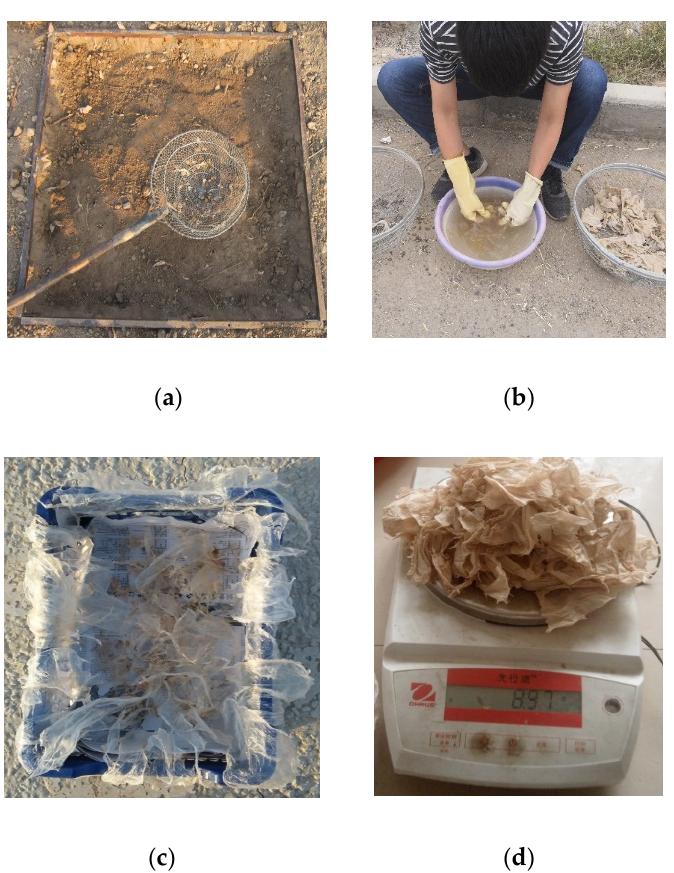
Figure 4. Shows the treatment process for measuring quality of residual PF: ( a ) selecting an area of 1 m 2 in the test site and collecting the residual PF in the soil within 150 mm depth, ( b ) cleaning the residual PF, ( c ) drying the residual PF after cleaning, ( d ) measuring the quality of the residual PF and obtaining experimental data.